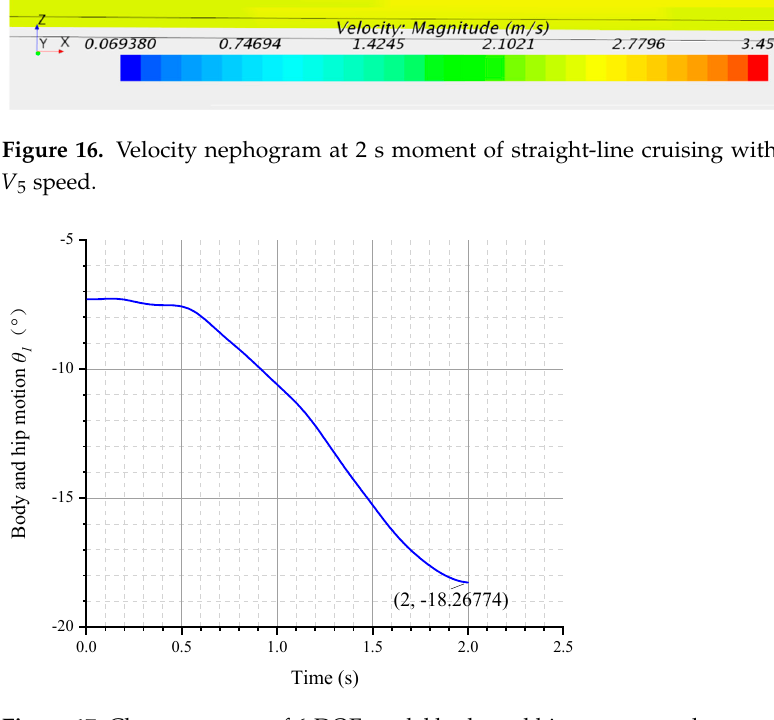
Figure 17. Change process of 6-DOF model body and hip posture angle.